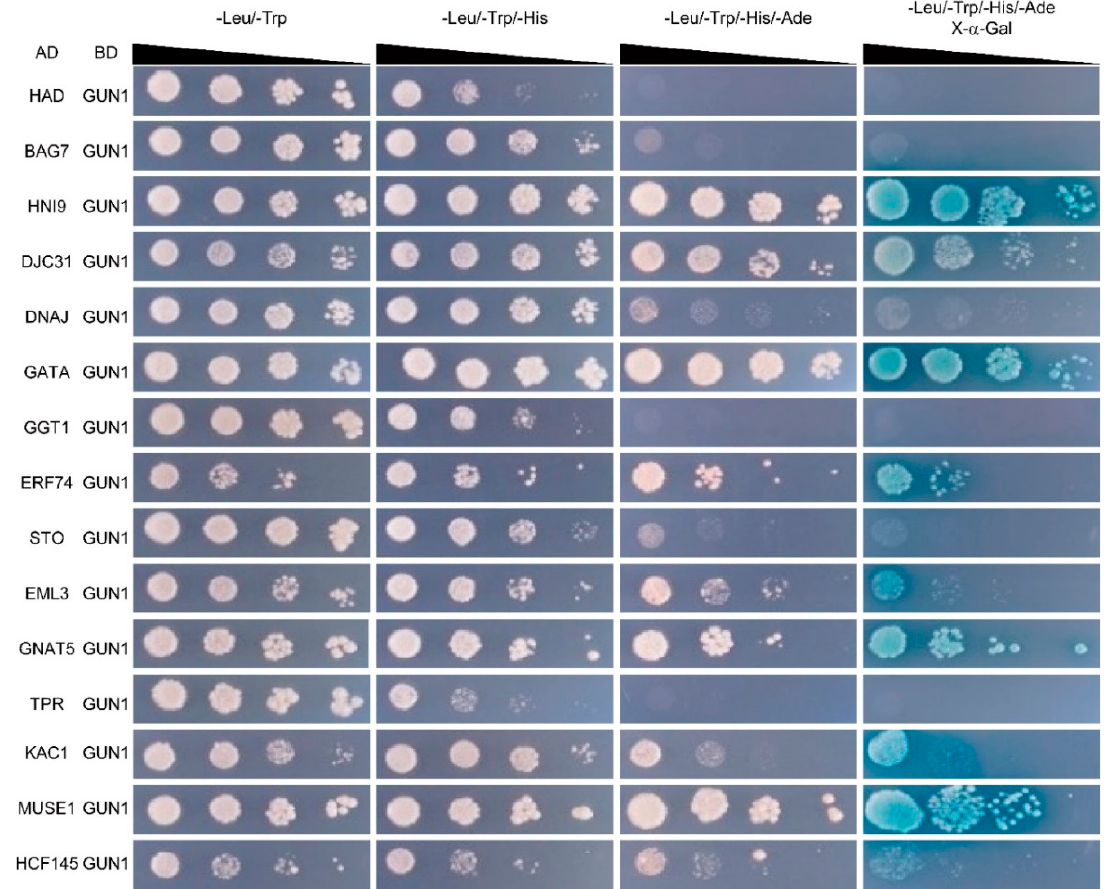
Figure 1. Yeast two-hybrid assay showing the interactions between GUN1 and its candidate partners. GUN1 was fused with the GAL4 DNA binding domain (BD), and each of the candidate proteins was fused with the GAL4 activation domain (AD). Ten-fold serial dilutions of yeast cells expressing different protein pairs as indicated were spotted on non-selective double drop-out (DDO, SD/-Leu/-Trp) and selective triple (TDO, SD/-Leu/-Trp/-His) and quadruple (QDO, SD/-Leu/-Trp/- His/-Ade) drop-out media. To the QDO medium, X- α -Gal was added parallel to indicate the activation of α -galactosidase by the protein–protein interactions.